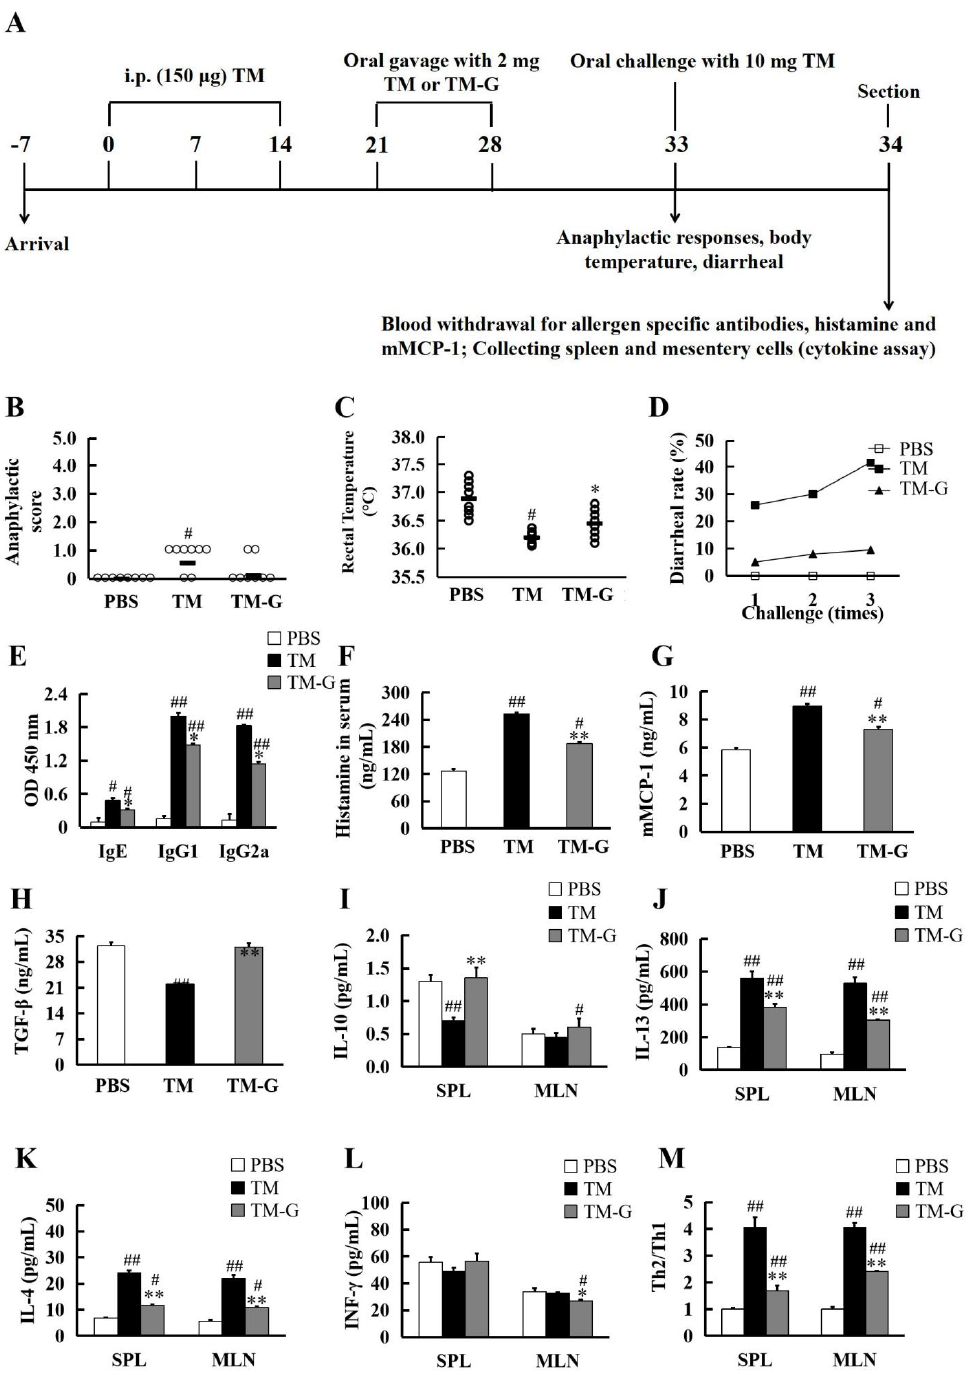
Figure 5. Oral tolerance induced by TM-G: ( A ) Experimental design of oral tolerance. ( B ) Anaphy- lactic scores. ( C ) Rectal temperature was measured 1 h after intragastric TM delivery. ( D ) Rates of diarrhea for 1 h after every challenge. ( E ) The levels of IgE, IgG1, and IgG2a in the serum of mice on day 34 were measured. ( F – H ) The levels of histamine, mMCP-1, TGF- β measured in sera (dilution 1:5, 1% skimmed milk). ( I – L ) The production of IL-10, IL-13, IL-4, and IFN- γ was measured in cultured spleen lymph cells and mesentery lymph cells, respectively. ( M ) The ratio of Th2/Th1. All data are presented as the mean ± SD ( n = 3). # p < 0.05 and ## p < 0.01 was used to compare with PBS group. * p < 0.05 and ** p < 0.01 was used to compare with TM